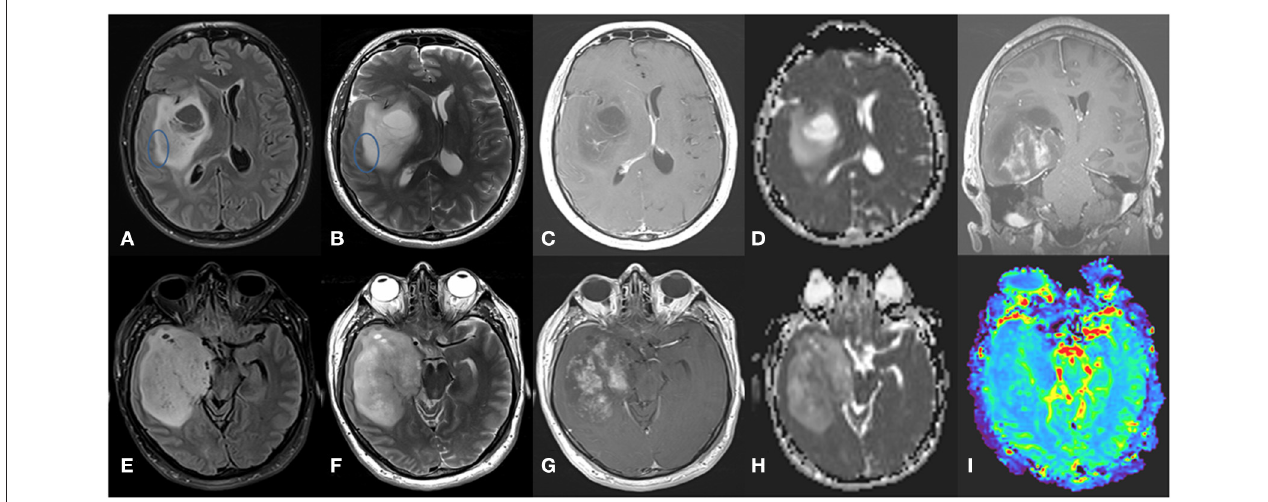
FIGURE 3 | Grade 4 IDH-mutant astrocytoma. (A) axial FLAIR, (B) axial T2-weighted image, (C) axial T1-weighted image with contrast, and (D) ADC map in the superior aspect of the lesion, showing a large infiltrative and expansive insular lesion. Note the partial T2-FLAIR mismatch sign at its lateral margin (circle) and extensive NCE component with no or only subtle enhancement with high ADC values. These findings indicate IDH-mutant astrocytoma. In contrast, the inferior aspect of the lesion (E–H) has a more heterogeneous T2 signal with hypointense areas corresponding to low ADC values and elevated rCBV in perfusion map (I) and intense poorly delimited enhancement with small necrotic areas. These findings indicate a high-grade